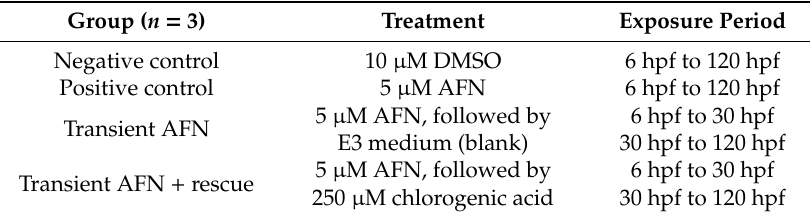
Table 1. Treatments received by zebrafish